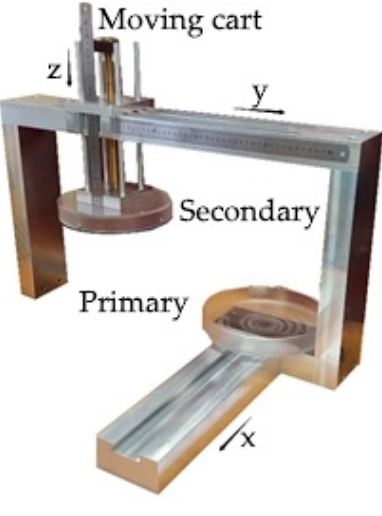
Figure 5. Movement base.